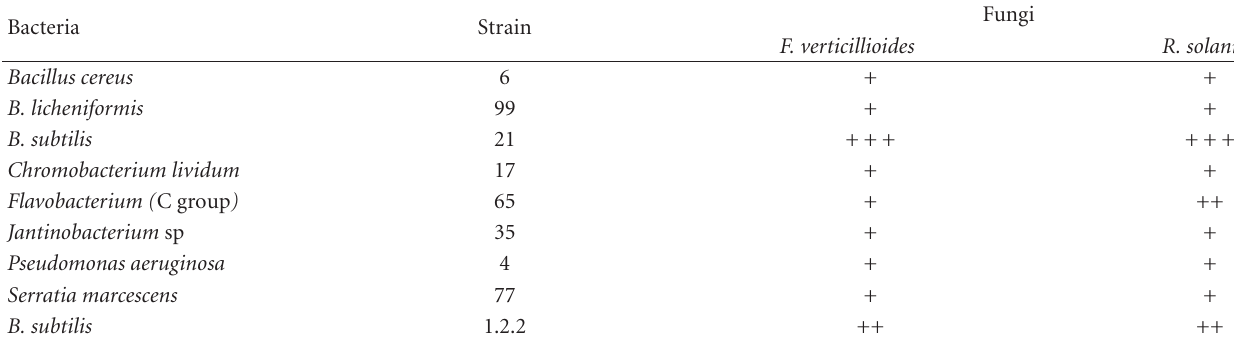
Table 1: Antifungal activity of bacteria isolated from strawberry plants a .